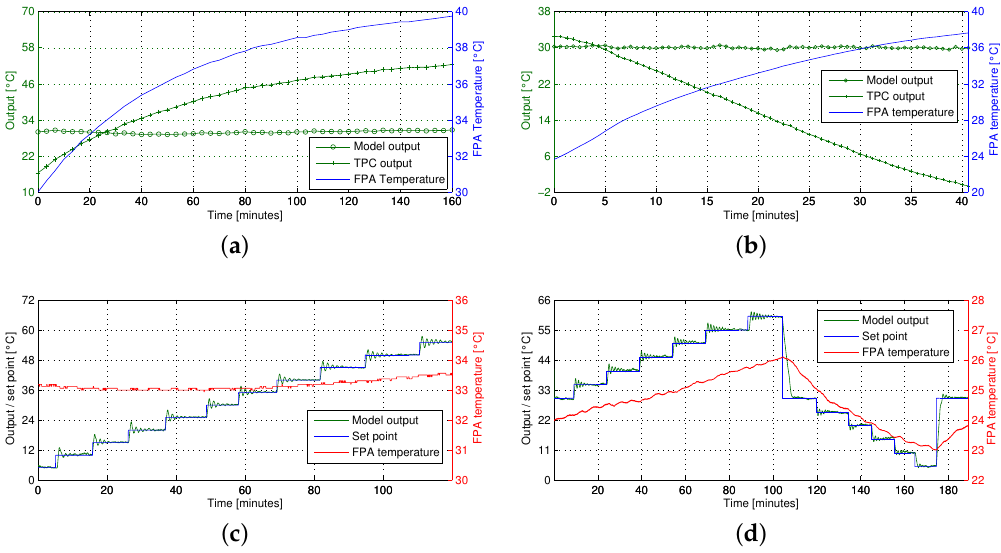
Figure 6. Model output with varying FPA and black-body temperature. ( a ) Model and TCP output with varying T FPA , CEDIP camera; ( b ) Model and TCP output with varying T FPA , FLIR core; ( c ) Model output with varying black-body temperature, CEDIP camera; ( d ) Model output with varying black-body temperature, FLIR